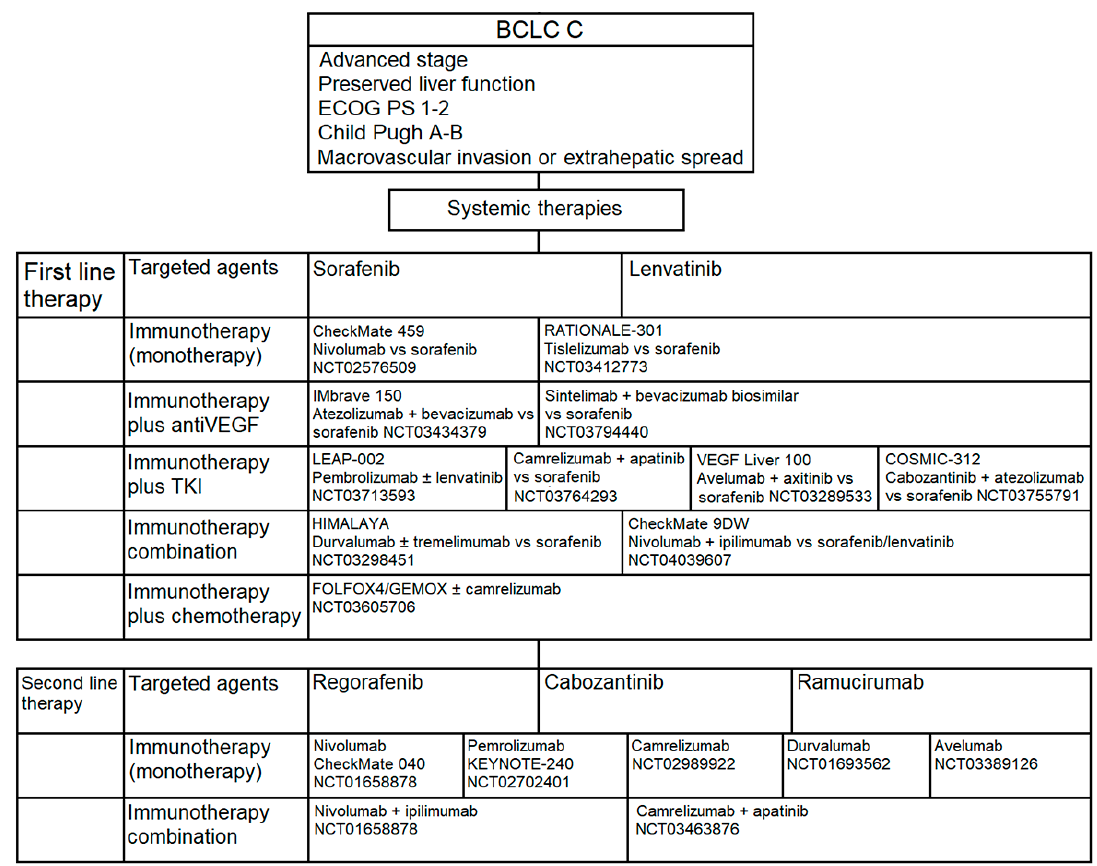
Figure 4. Treatment options and ICIs ongoing clinical trials for BCLC stage C.